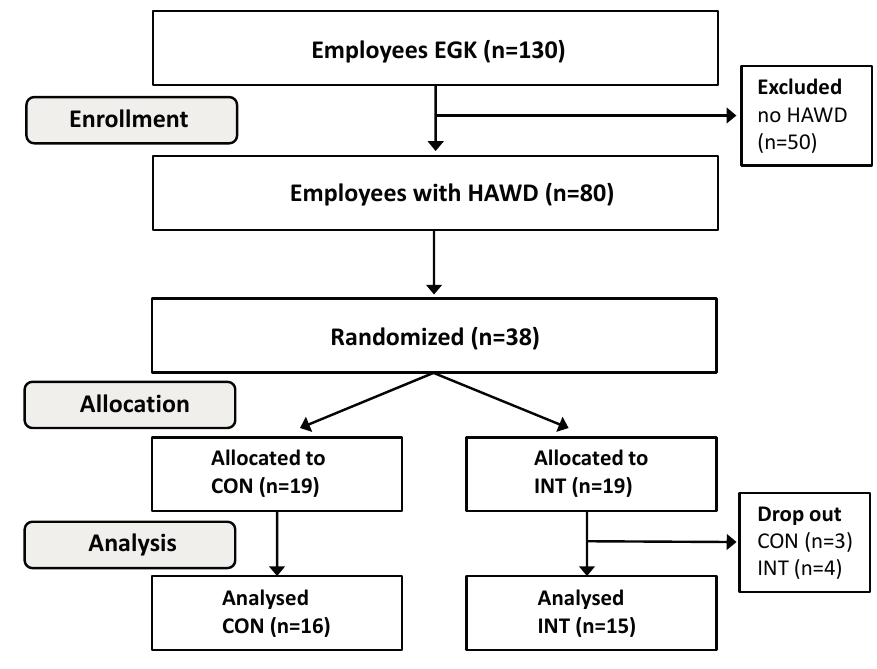
Figure 1. Participant flow throughout the